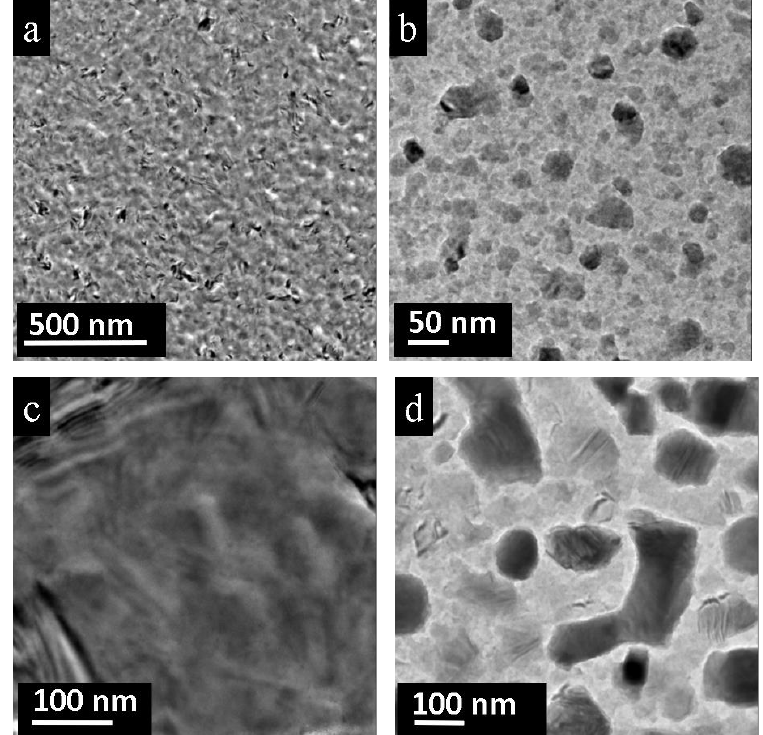
Figure 8. PbTe layers obtained by electron-beam treatment of the polycrystalline PbTe (pre-annealed at 400 °C) after additional heat treatment at 350 °C (1 h) . ( a , b ) Layers formed at a larger distance from the initial particle: ( a ) Overview of a layer composed of fine grains forming a dense packing with some dislocations within the layer. ( b ) In addition, less dense and more inhomogeneous covering occurs revealing individual isolated grains and roundish nano-particles. ( c , d ) Layers formed very near to the initial particle: ( c ) Homogenous film is observed in direct vicinity of the initial crystal. ( d ) At the edges, layers composed of isolated, large nano-bars occur near the source particle.